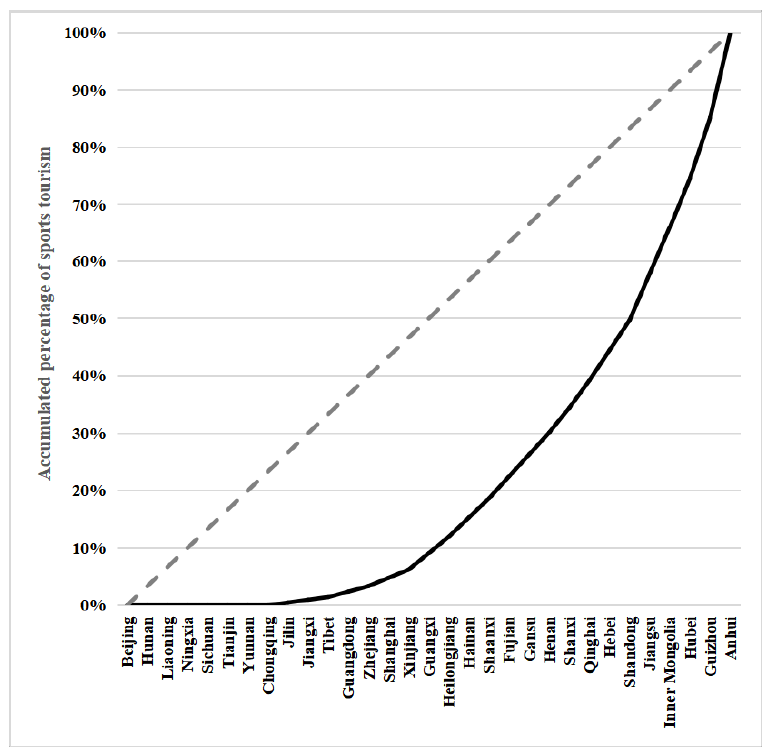
Figure 2. Lorentz curve of the distribution of China's sports tourism resources in 2014.